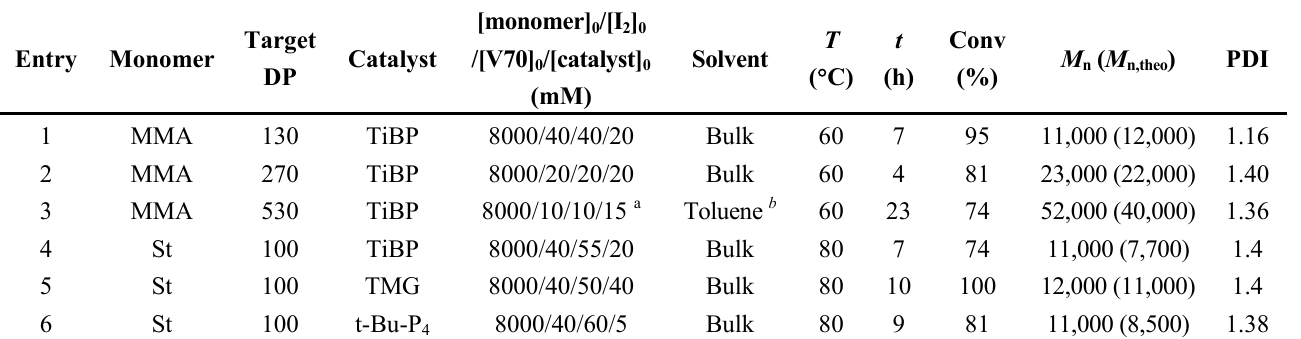
Table 3. Polymerizations of MMA and St with in Situ Generated Alkyl